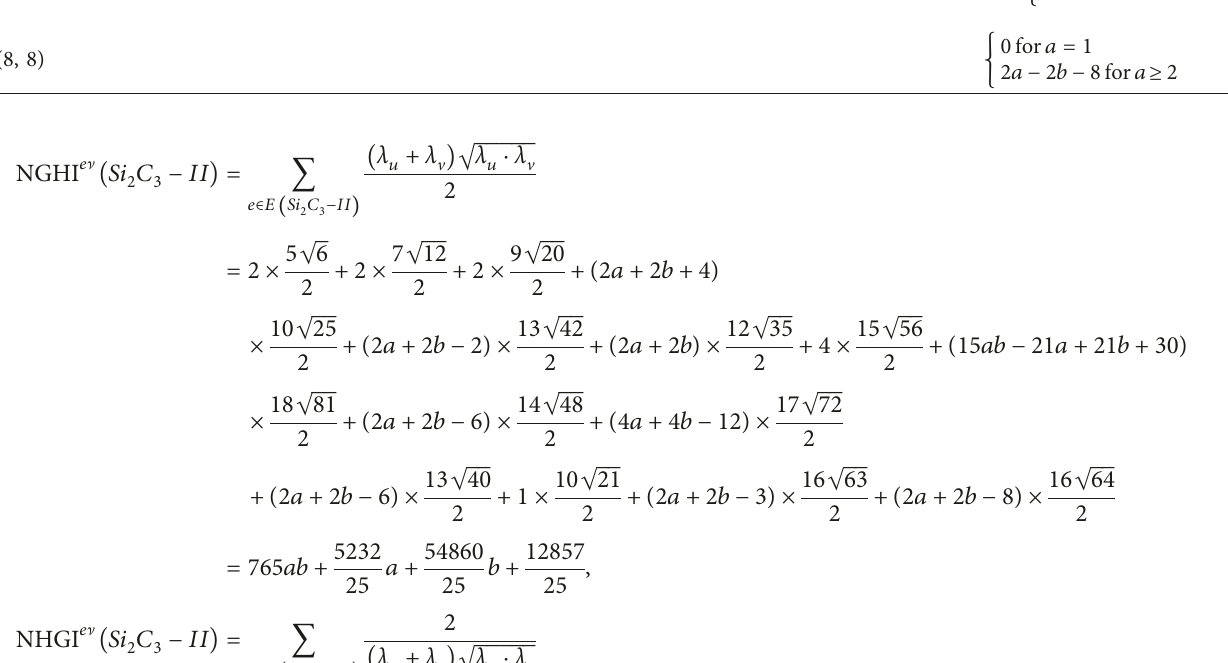
Table 7: The number of edges of Si